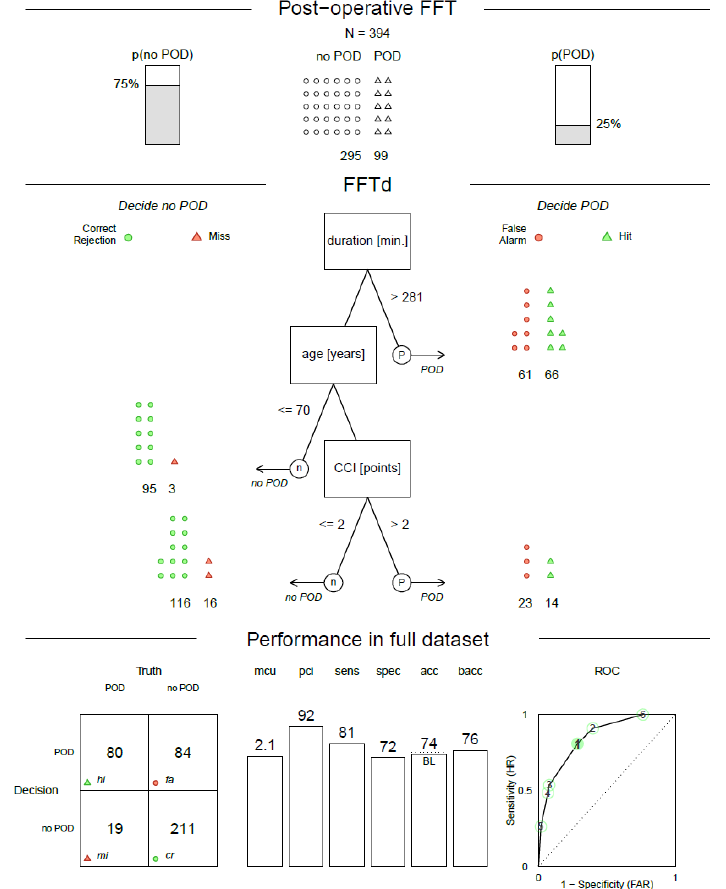
Figure 5. Postoperative fast-and-frugal tree estimated with the dfan algorithm. POD — postoperative delirium, p(POD) — probability of POD a priori (base rate), p (no POD) — complement of p(POD), FFTd — fast-and-frugal tree construction using the dfan algorithm, duration — duration of anesthe- sia, CCI — Charlson Comorbidity Index, mcu — mean cues used, pci — percent cues ignored, sens — sensitivity, spec — specificity, acc — unweighted accuracy, back — balanced accuracy (sensitivity +